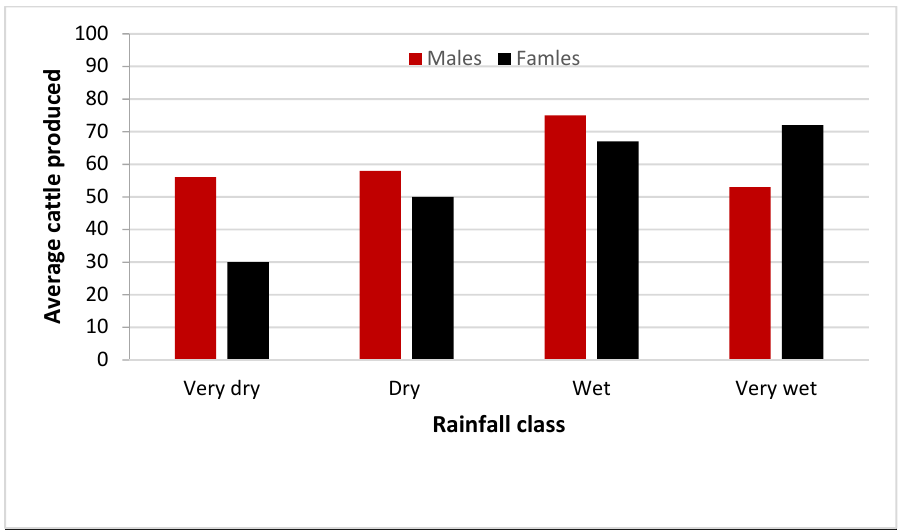
Figure 7. Annual average yield of cattle produced by male- and female-headed household grazing game players in UER (n female games = 22; n male games = 22).